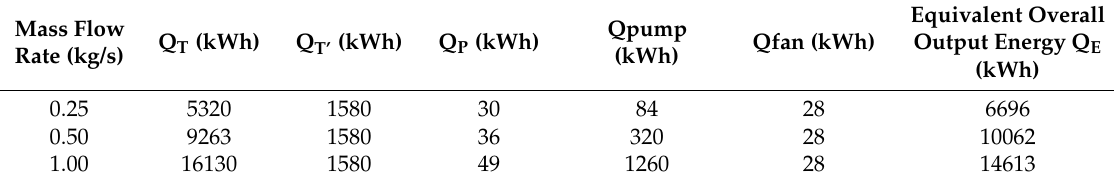
Table 5. Time − wise results of mass flow rate